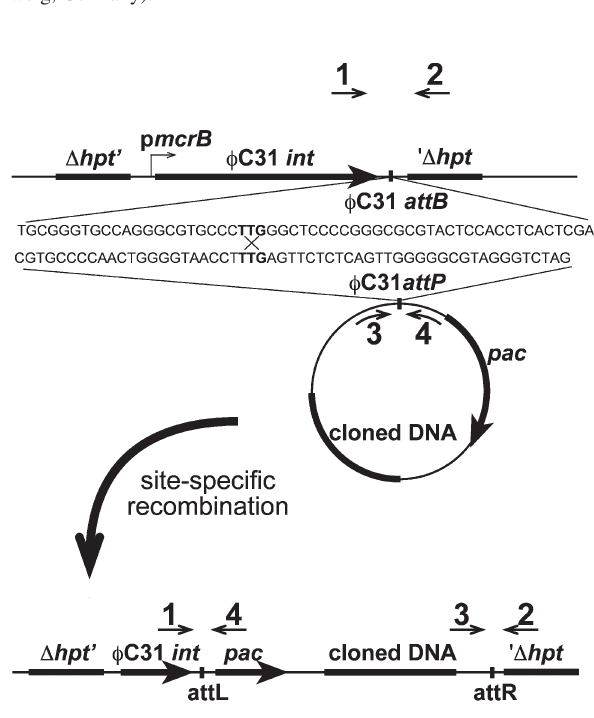
Figure 1. Scheme of the φ C31 integrase-mediatedsite-specific recom- bination in Methanosarcina . Strains carrying the φ C31 integrase gene ( φ C31 int ) driven by a strong constitutive promotor (P mcrB ) and the phage integration site ( φ C31 attB) inserted into the hpt locus of both Methanosarcina acetivorans and M. barkeri were constructed as de- scribed (Table 1). Transformation of these strains to Pur R (conferred by the pac gene) with non-replicating plasmids carrying the comple- mentary integration site ( φ C31 attP) results in highly efficient integra- tion of the plasmid into the host chromosome after site-specific recombination between attB and attP (denoted by X) catalyzed by the Int protein. hpt and Δ hpt represent the chromosomal regions flank- ing the hpt locus, which was deleted upon insertion of the int gene and attsites.attLand attRrepresentthe hybridrecombinationsitesformed by site specific recombination between attB and attP. The numbered arrows indicate the location of PCR primers used to verify the sin- gle-copy insertion of plasmids as described in the methods. Se- quences for the screening primers are provided in Table